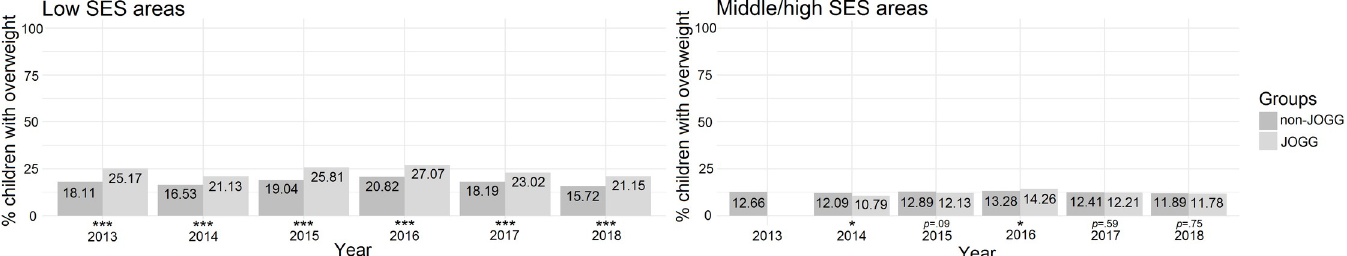
Fig 4. Prevalence of overweight in JOGG areas and non-JOGG areas, separated by SES. Visual representation of overweight prevalence in non-JOGG areas and JOGG areas between 2013–2018, separated by SES. On the left, low SES groups are visualized, while middle/high SES groups are visualized on the right. � p < .05; �� p < .01; ��� p < .001.